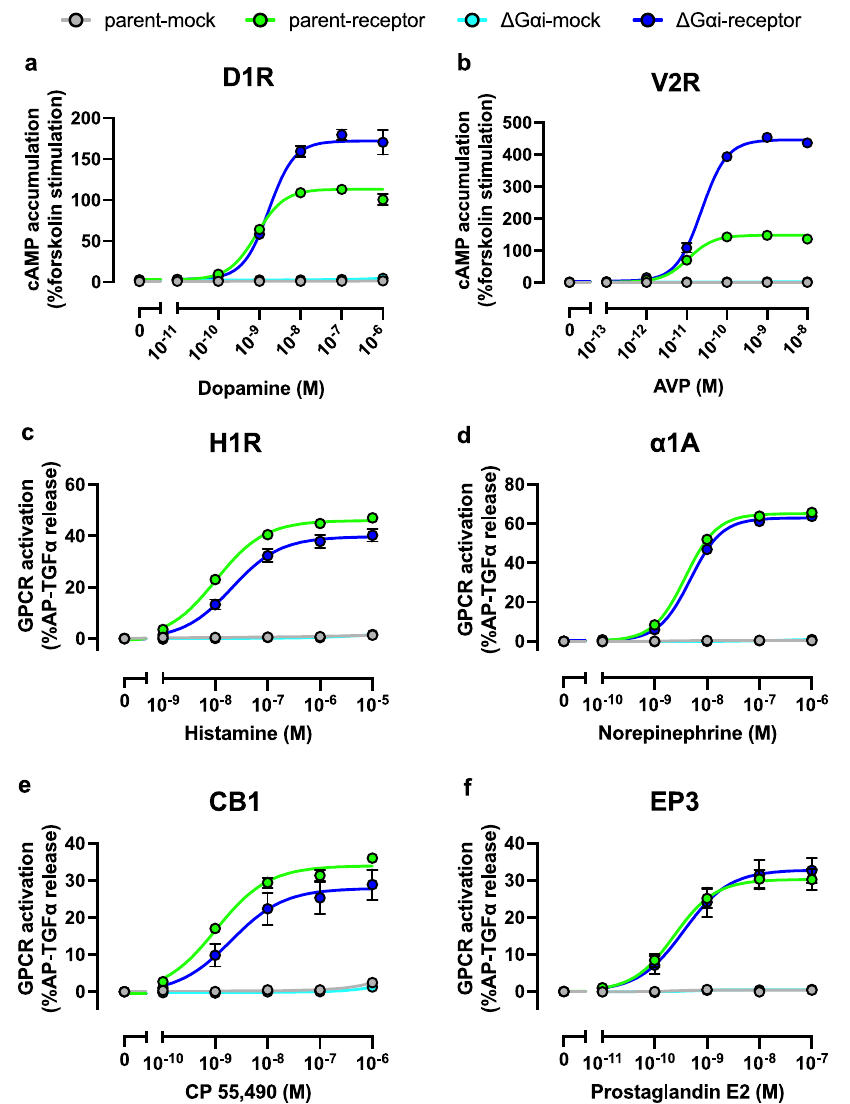
Fig. 3 Assessing Gs, Gq, and G12 signaling in Δ G α i cells. a , b Concentration-response curves of Gs-mediated cAMP accumulation. Parent and Δ G α i cells transiently expressing Glo-22F together with either D1R ( a ) or V2R ( b ) were stimulated with the indicated concentrations of dopamine or arginine vasopressin (AVP), respectively. c – f Concentration – response curve of the TGF α shedding responses induced by Gq- (H1R ( c ) and α 1A ( d )) and G12- coupled receptor (CB1 ( e ) and EP3 ( f )) activation in parent and the Δ G α i cells. A test GPCR was expressed in the parent and the Δ G α i cells along with the AP-TGF α reporter, and the resulting ligand-induced response was assessed. In all fi gures, symbols and error bars represent the mean and SEM, respectively, of three independent experiments. Each experiment was performed in triplicate. Note that for many data points, error bars are smaller than the size of the symbols, and thus are not